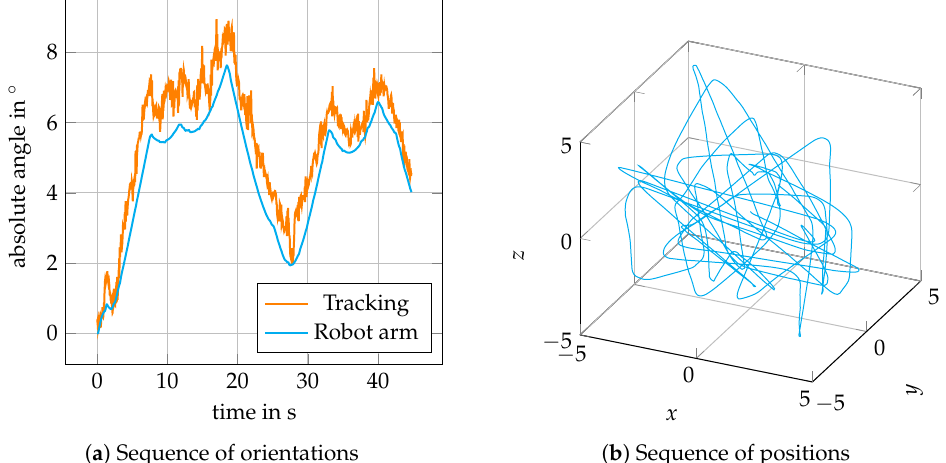
Figure 15. Exemplary trajectory for random 6D motion. The robot arm changes its end-effector orientation randomly at 1 ◦ /s up to 8 ◦ from its initial orientation ( a ). At the same time, the robot arm translates the phantom randomly within a 10mm